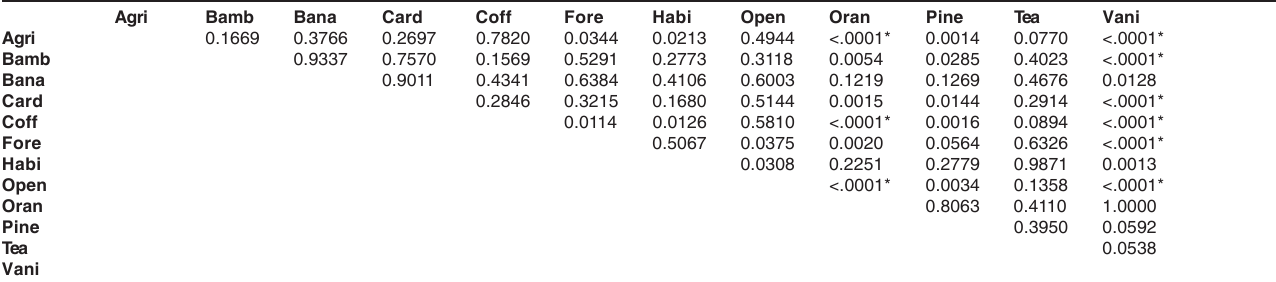
Table 7. Significant variance in Shannon-Wiener Diversity index between habitats using modified t-test by Hutcheson (1970). Agri Bamb Bana Card Coff Fore Habi Open Oran Pine